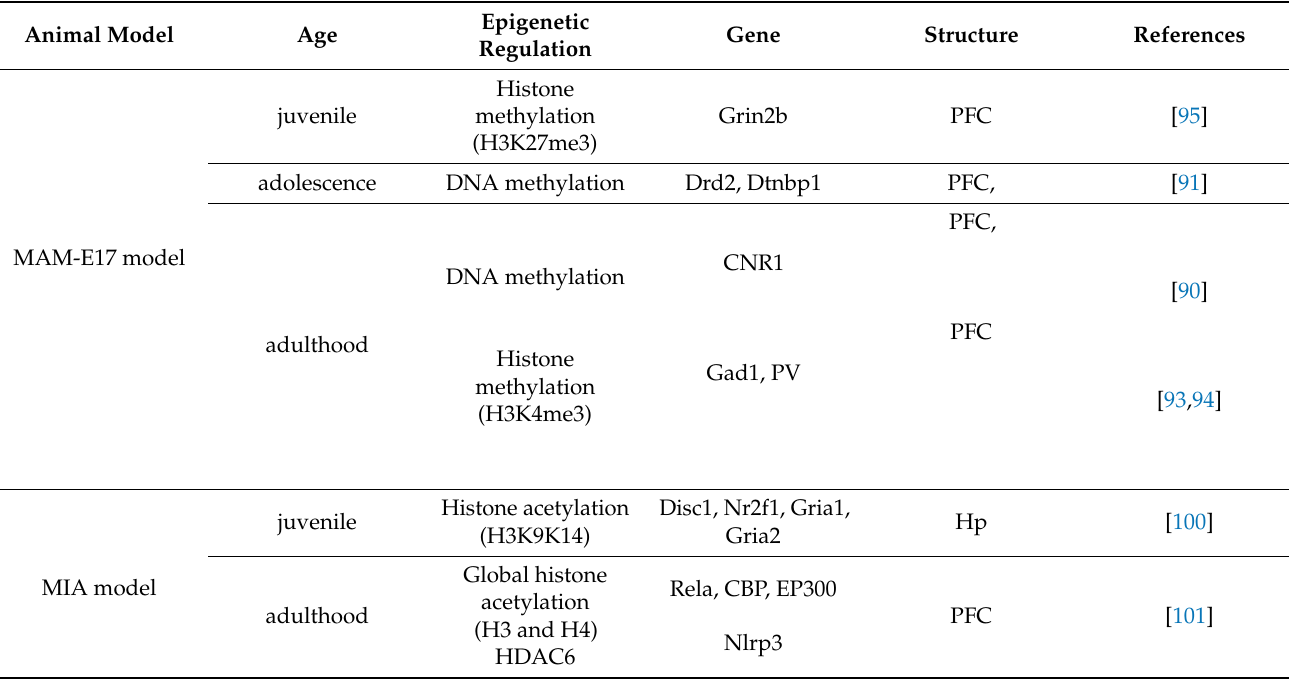
Table 2. Epigenetic regulation of gene expression in animal models of